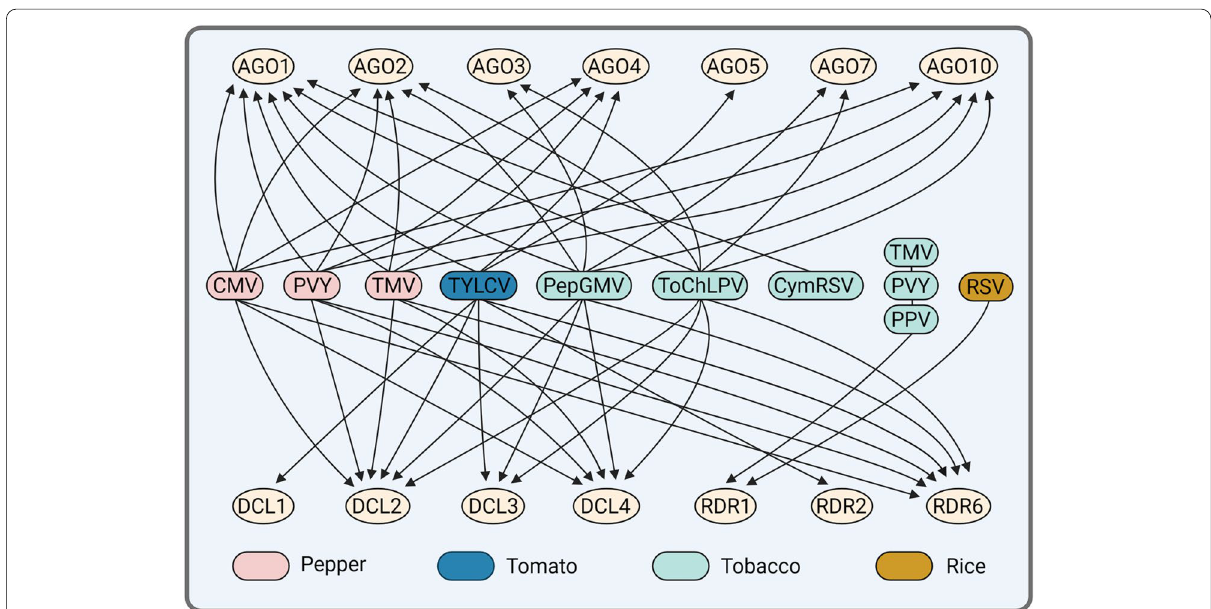
Fig. 3 Different host and virus lead to diverse RNAi components expression. The RNAi components shown in ovals generally have been induced by different